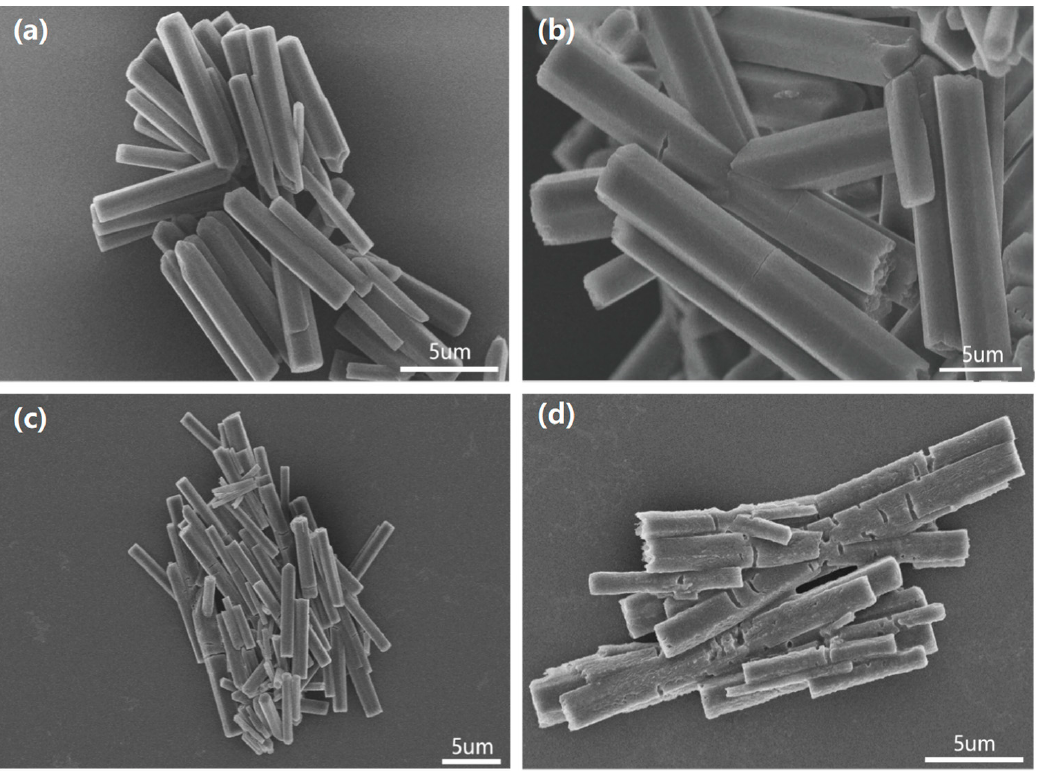
Figure 1. SEM images of ( a ) as-prepared hybrid assemblies and hybrid assemblies exposed to ( b ) 0.1 ug/mL, ( c ) 1 ug/mL and ( d ) 10 ug/mL of Pb 2+ solution.